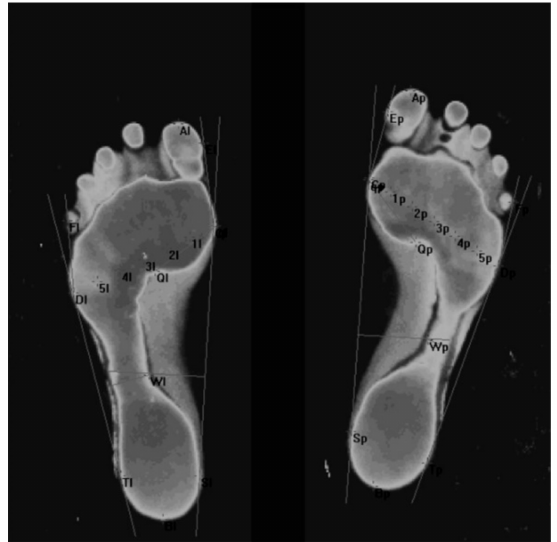
Figure 3. Example of a footprint scan computer